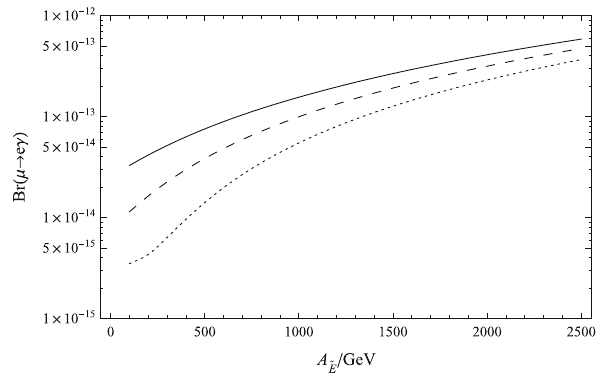
Fig. 8 With Y e 5 = 1 . 0 ( 1 . 5 , 2 . 0 ) , the branching ratios of μ → e γ versus parameter A ˜ are plotted by the dotted, dashed and solid lines E respectively